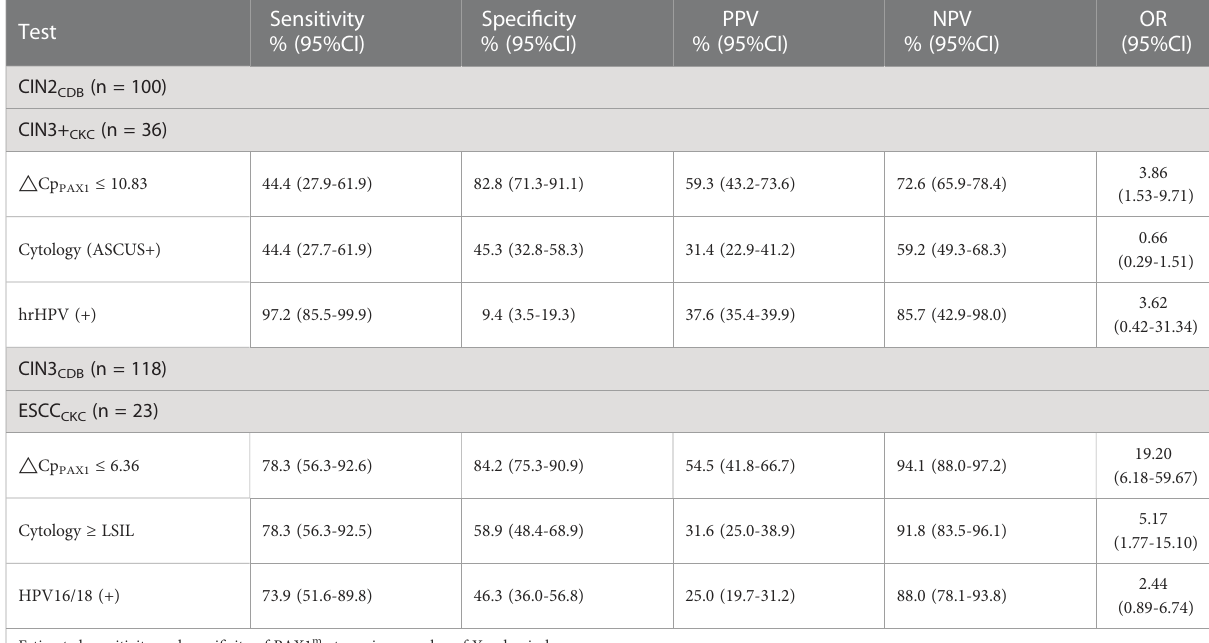
TABLE 3 The Performance of D Cp PAX1 in predicting CIN2 upgrade to CIN3, and CIN3 upgrade to ESCC after conization.